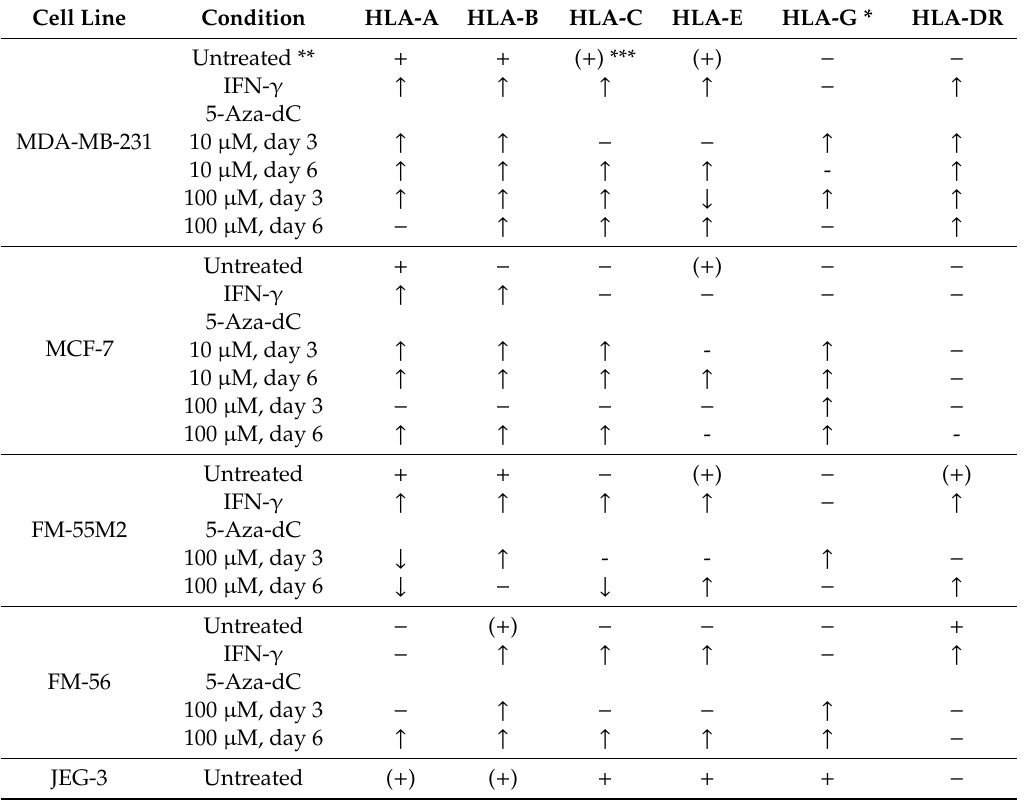
* Combined results for HLA-G surface expression and mRNA